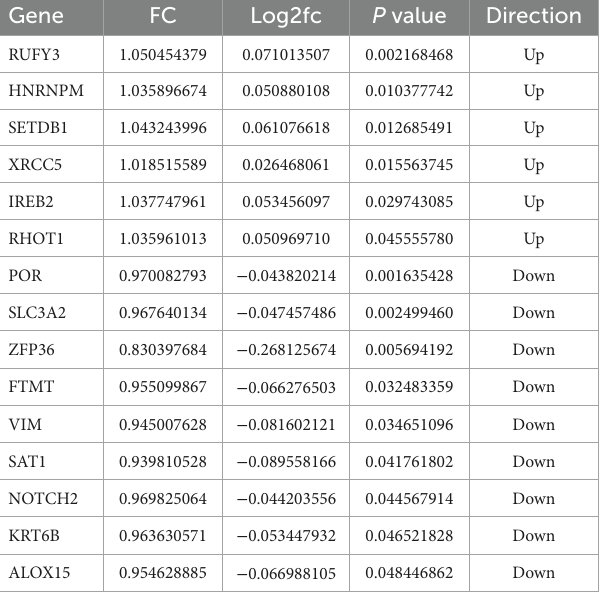
TABLE 2 Integrate 15 expressed differentially regulated genes related to